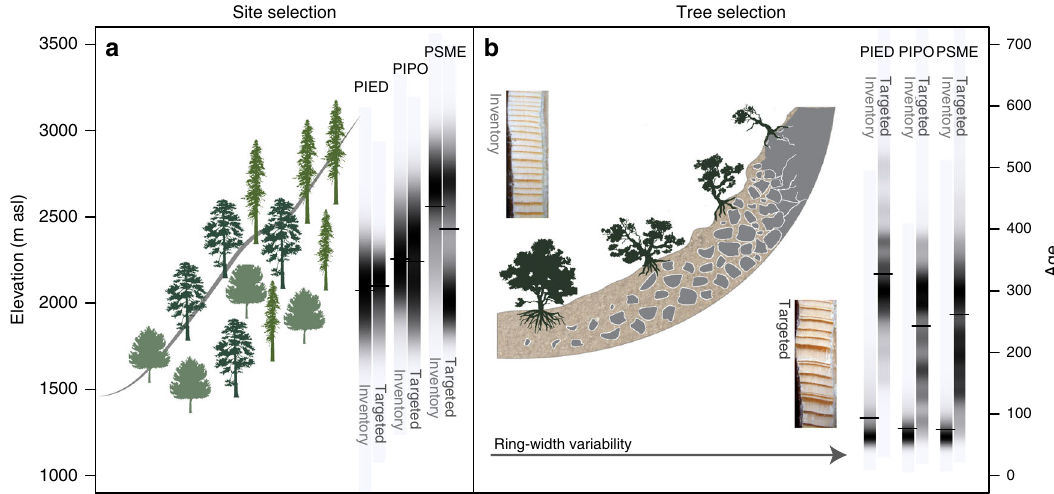
Fig. 1 The site and tree selection principles of dendrochronology. The majority of tree-ring time series in the International Tree-Ring Data Bank (ITRDB) were sampled to maximize chronology length and climate sensitivity. a Comparison of the elevation at which three important species (PIED = Pinus edulis , PIPO = Pinus ponderosa , PSME = Pseudotsuga menziesii ) were sampled in Arizona, Colorado, New Mexico, and Utah. A bias towards sampling low-elevation sites (therefore, warmer and drier) is evident for ITRDB samples of PSME compared to the representative inventory (Forest Inventory and Analysis; FIA) dataset, leading to a “ macro-site selection bias ” . b Selection of trees on steep, rocky slopes with little soil water holding capacity leads to greater ring-width variability (modi fi ed from Fritts 14 ). We hypothesize that this sampling practice — the “ micro-site selection bias ”— explains higher standard deviation of ring- width index in the ITRDB collection (Fig. 2), even after accounting for elevation, age, and other factors. Vertical bars show the age distribution of the two collections in 1995. Tick marks indicate the median in each density